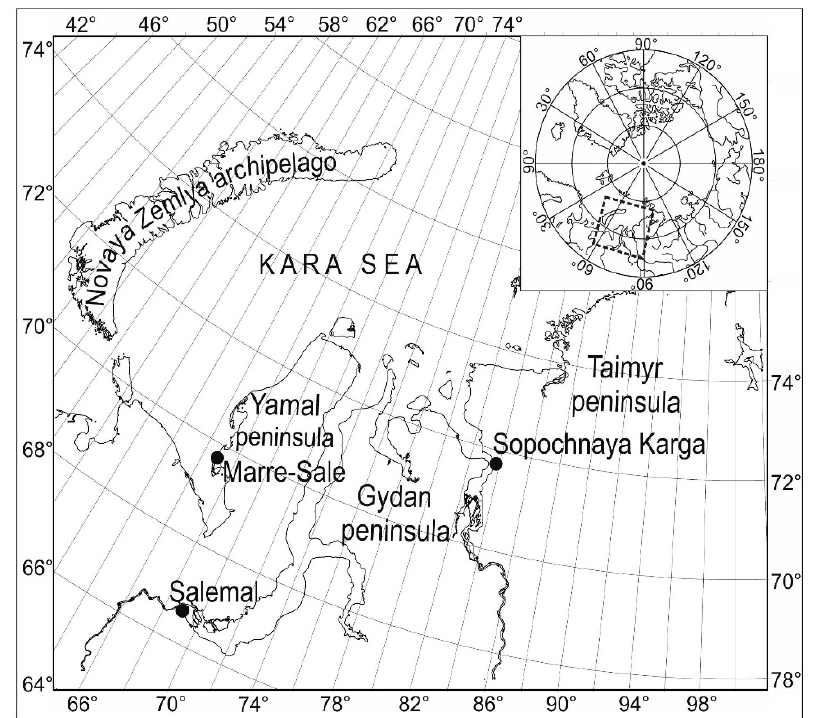
Figure 1. Study area map showing the location of three study key sites.